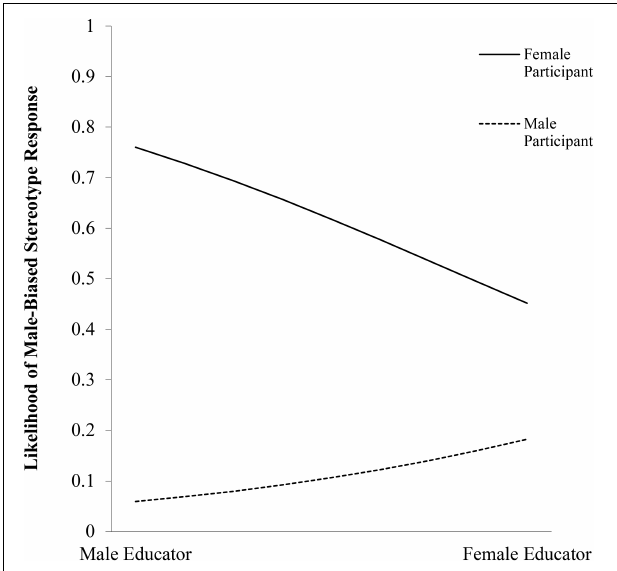
FIGURE 2 | Likelihood of male-biased stereotype response as a function of participant gender and educator